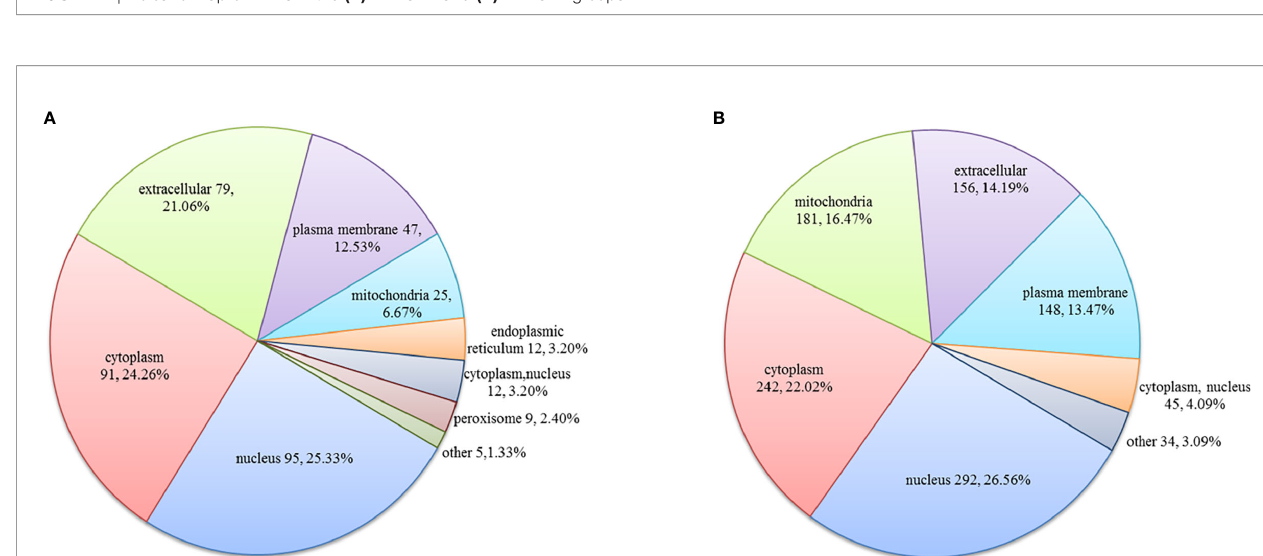
FIGURE 1 | Volcano map of DEPs in the (A) HT vs . H and (B) HT vs . T groups.